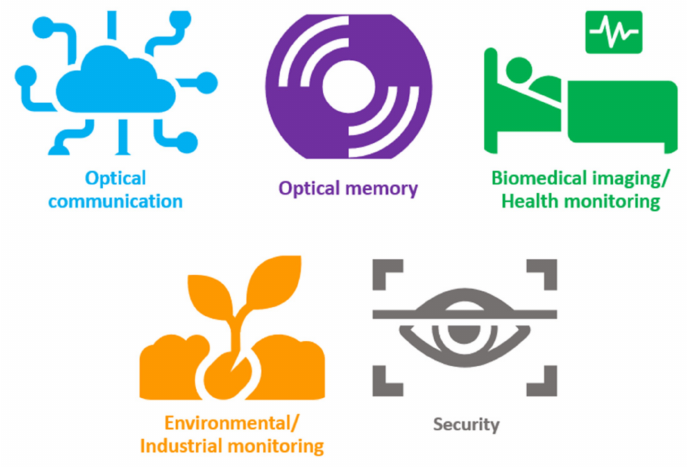
Figure 1. Examples of the application areas for